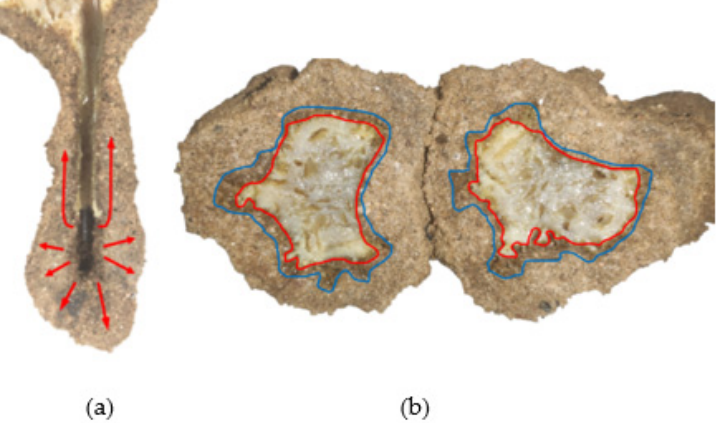
Figure 11. Section and profile of chemical grouted sands: ( a ) test 1 profile; ( b ) test 2 section. The area marked in red is the slurry bubble area; the slurry in the sand occurred in